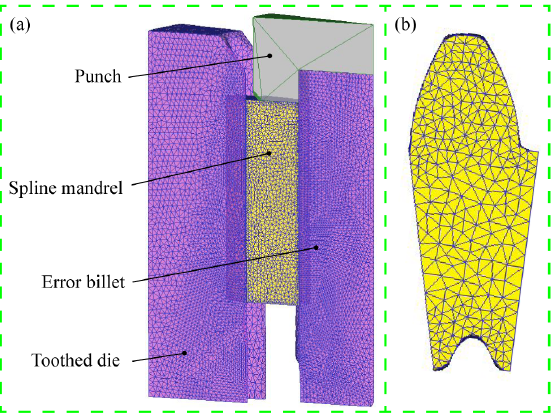
Figure 4. Numerical simulation model of precision finishing: ( a ) Assembly bodies and ( b ) cross section of billet. Table 2. Parameters for the FE simulation.